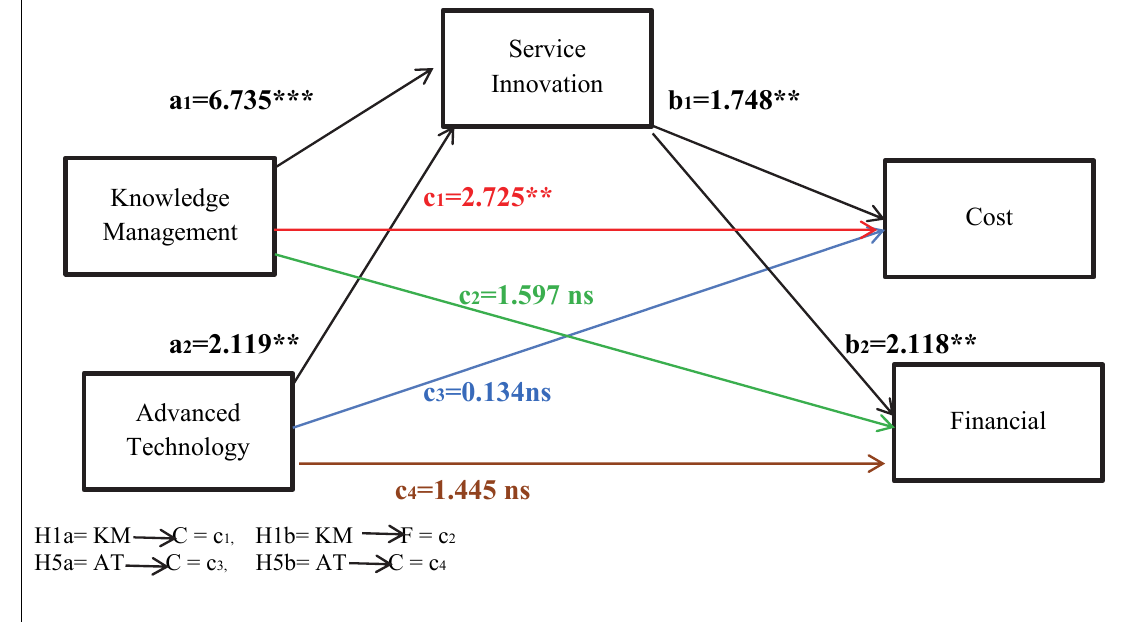
Fig. 2. Results of the modeling